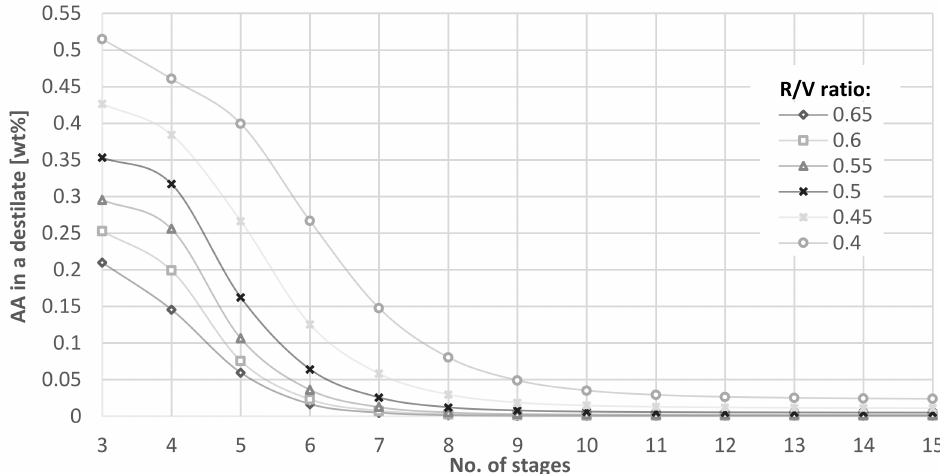
Figure 3. The influence of R/V ratio and the number of stages on the acetic acid content in distillate of the azeotropic column.